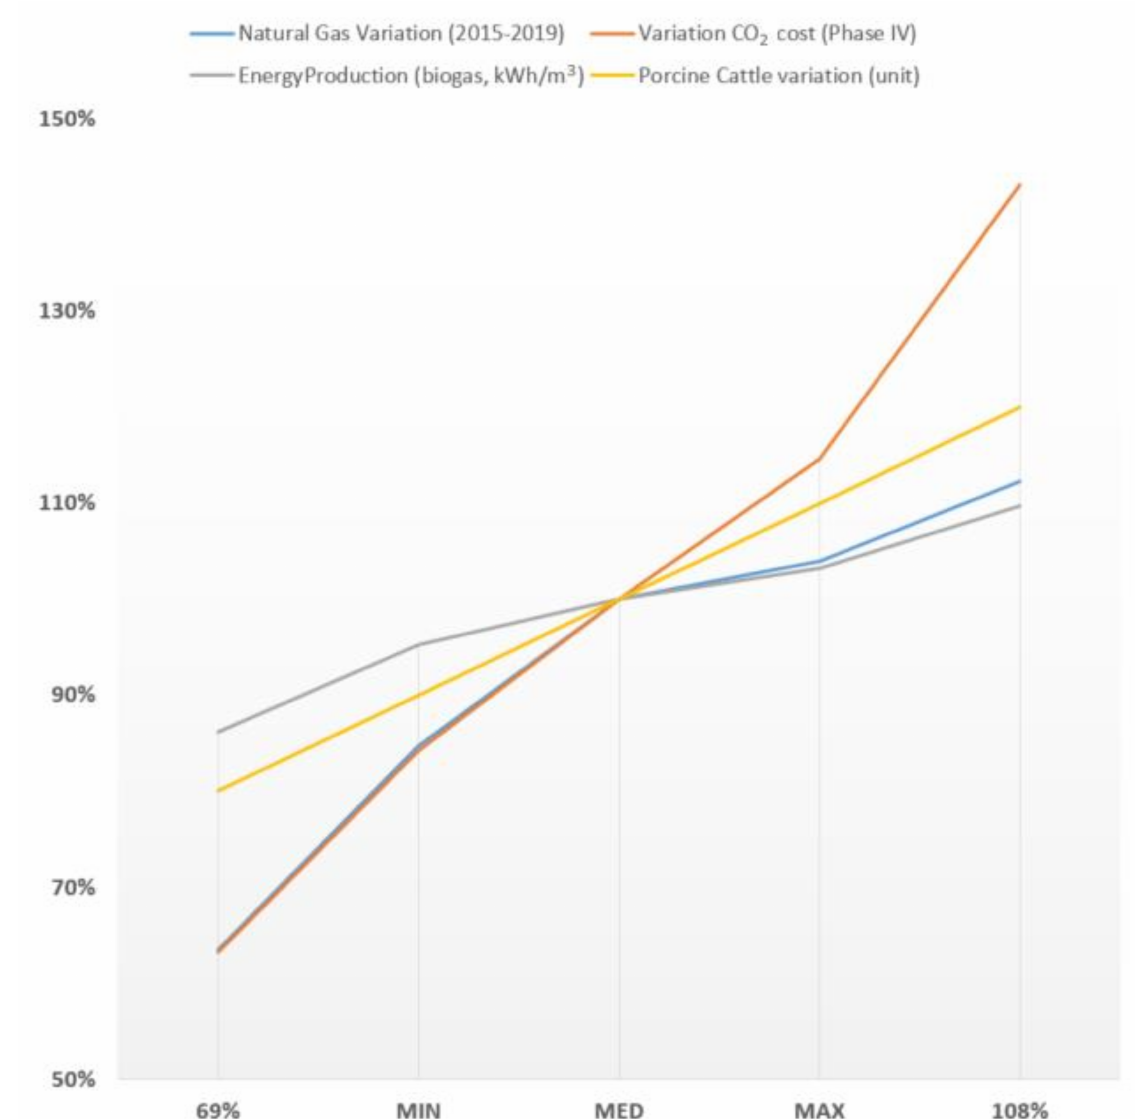
Figure 5. Sensitivity analysis for the different parameters